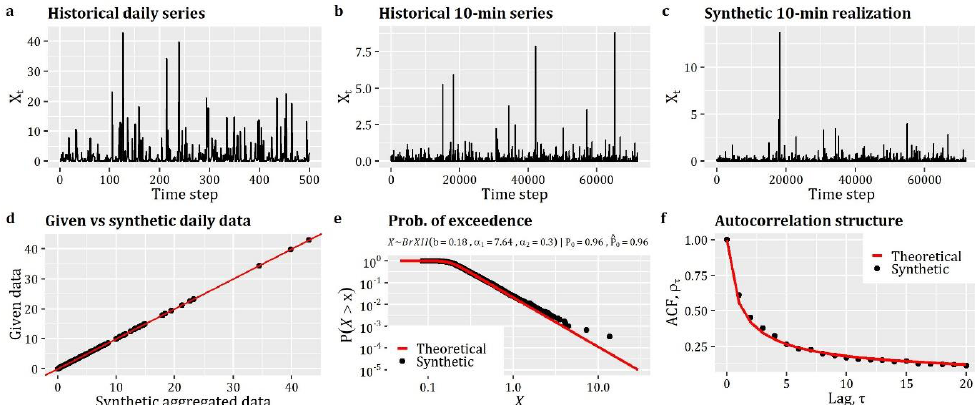
Figure 9. Historical ( a ) daily and ( b ) 10-min rainfall series; ( c ) synthetic (disaggregated) 10-min rainfall realization; ( d ) consistency check, comparing the values of the aggregated synthetically generated 10-min data, i.e., when aggregated to daily scale, with the corresponding target values; ( e ) comparison of distribution function of non-zero amounts for 10-min historical and disaggregated series (the fitted theoretical model is shown with red line); and ( f ) comparison of autocorrelation function (ACF) for 10-min historical and disaggregated series (the fitted theoretical model is shown with the red line).